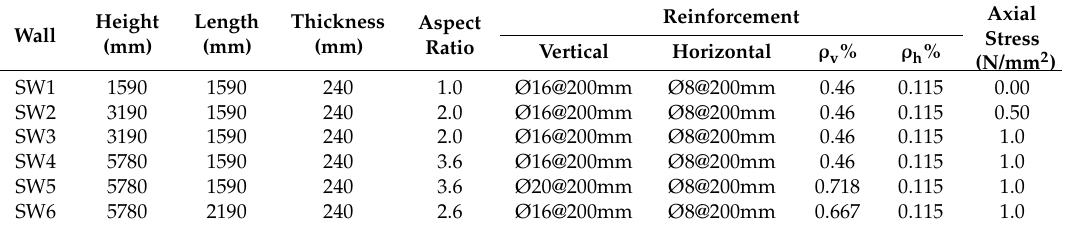
Figure 1. Self-insulating concrete masonry shear wall (SCMSW) specimen configurations. Figure 1. Self ‐ insulating concrete masonry shear wall (SCMSW) specimen configurations. Table 1. Self ‐ insulated concrete masonry shear wall (SCMSW) specimen details. Table 1. Self-insulated concrete masonry shear wall (SCMSW) specimen details.